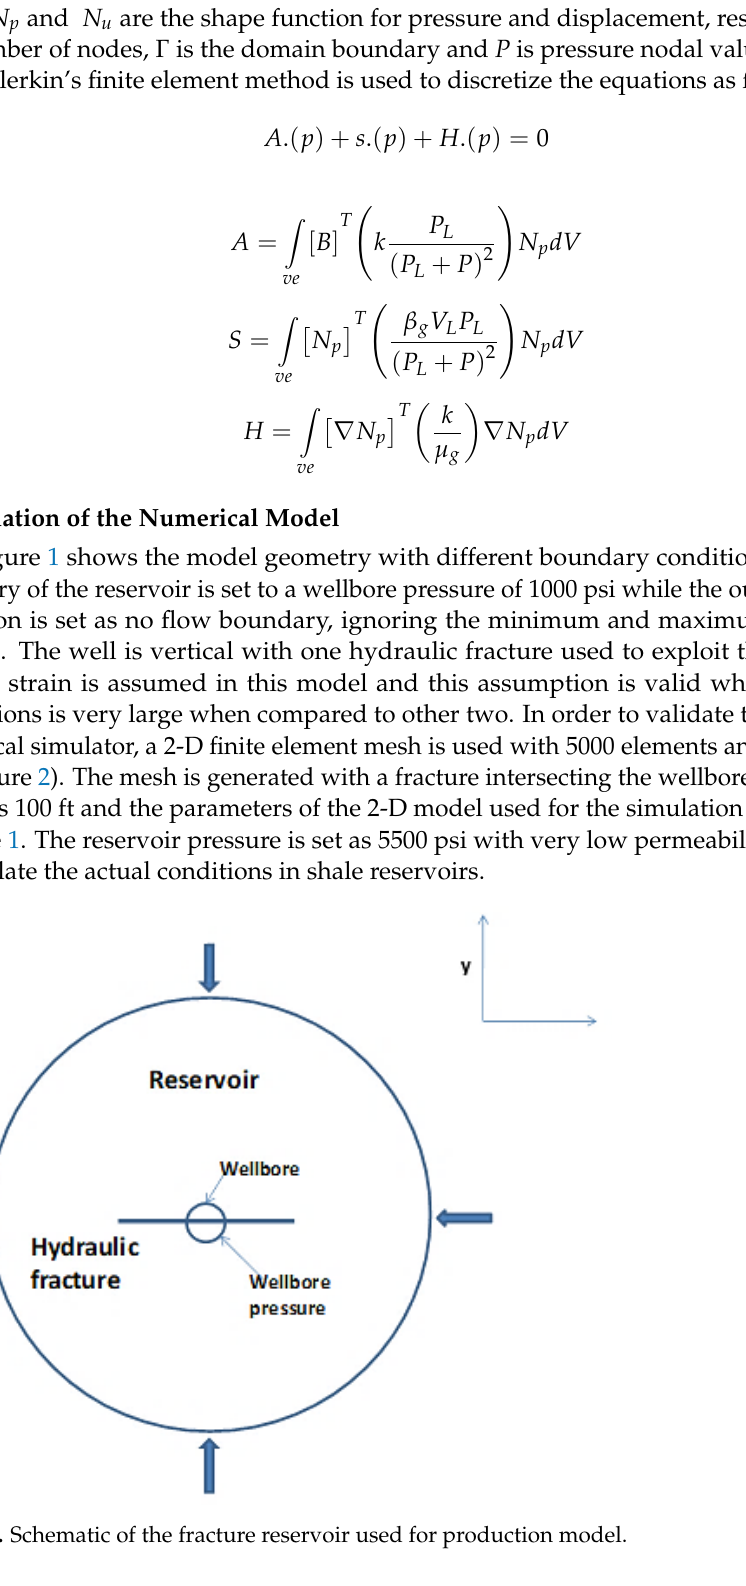
Figure 2. 2-D mesh used for the validation of the numerical model developed in this study. Table 1. Parameters used in the verification of the developed numerical model. Parameter